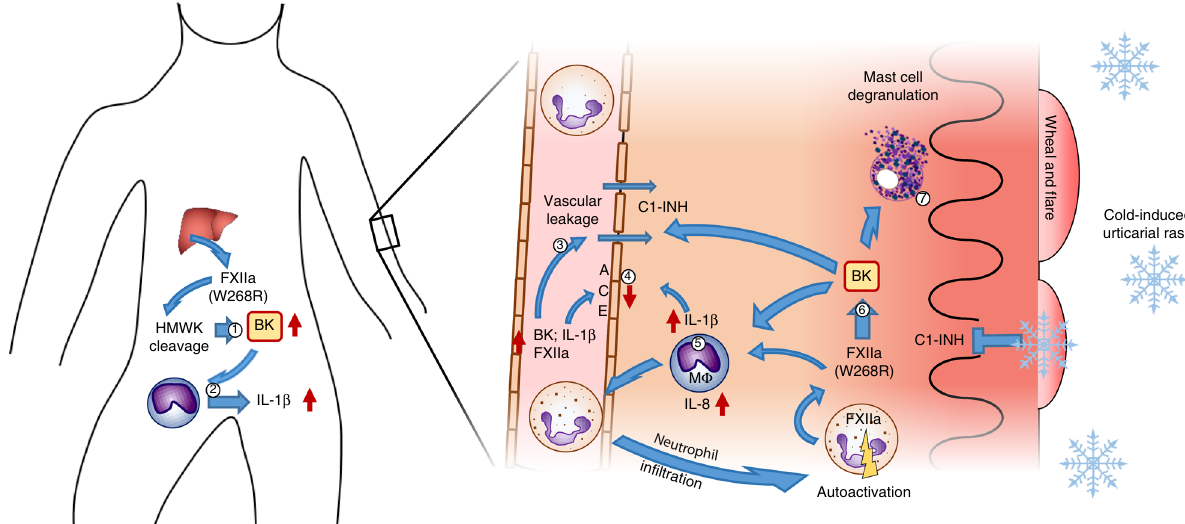
Fig. 7 Proposed pathomechanism underlying FXII W268R mutation in FACAS. Liver-derived and pre-activated FXII induces plasma prekallikrein cleavage, HMWK cleavage leading to constantly raised bradykinin (BK) levels in the patient plasma (1) and increased permeability of the vasculature (3). BK may also induce IL-1 β release from monocytes and tissue macrophages (M ɸ ) leading to the autoin fl ammatory phenotype observed in FACAS patients (2), (5). IL-1 β may further induce BK accumulation by upregulation of its receptors and downregulation of its inactivating enzyme ACE (4). In the skin, BK activates M ɸ to produce IL-8 and IL-1 β , recruiting neutrophils into the tissue (5). These neutrophils may act as a source of auto-activated FXIIa in the skin, which leads to further contact system activation and BK generation (6). Under normal conditions, C1-Inhibitor can control BK generation, however, upon cold exposure inhibitory capacity may drop leading to a local increase in BK. Activation of neutrophils may occur via a paracrine feedback loop involving plasma kallikrein and HMWK. In addition, BK may activate skin mast cells to release heparin and polyphosphates (7), which supports further activation of